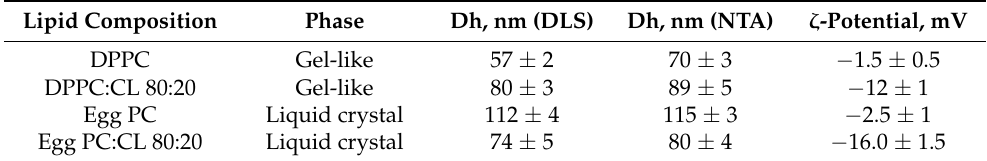
Table 1. Liposomes under consideration and their physicochemical characteristics. SD ( n = 3). 0.02 M Na-phosphate buffer solution, pH 7.4, 22 ◦